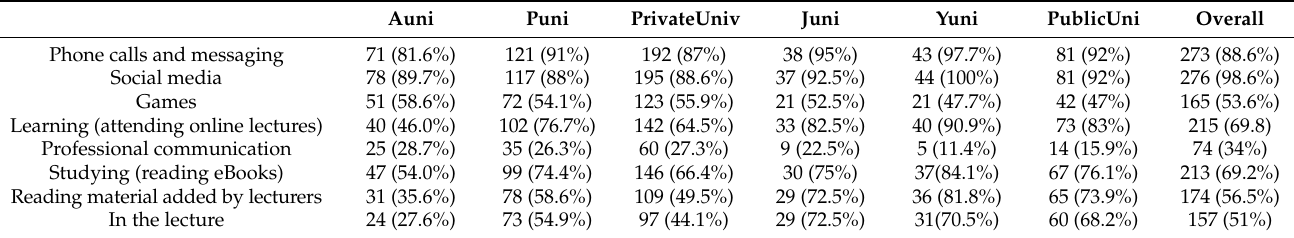
Table 3. Mobile device